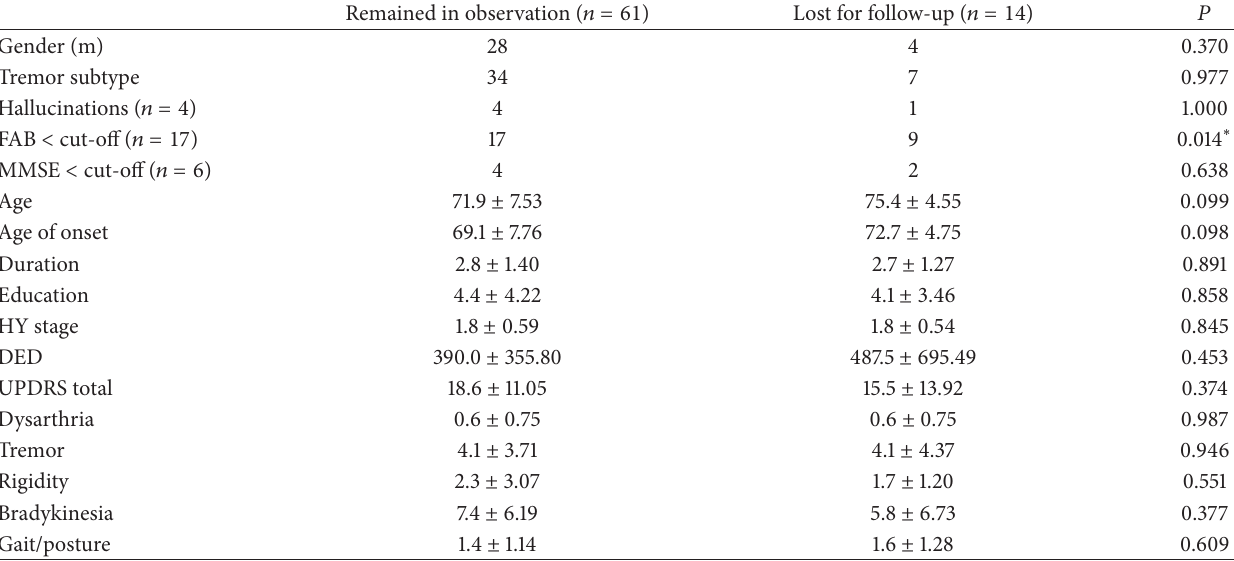
Table 1: Comparison between patients who remained in observation and those lost for follow-up. Remained in observation ( 𝑛 = 61